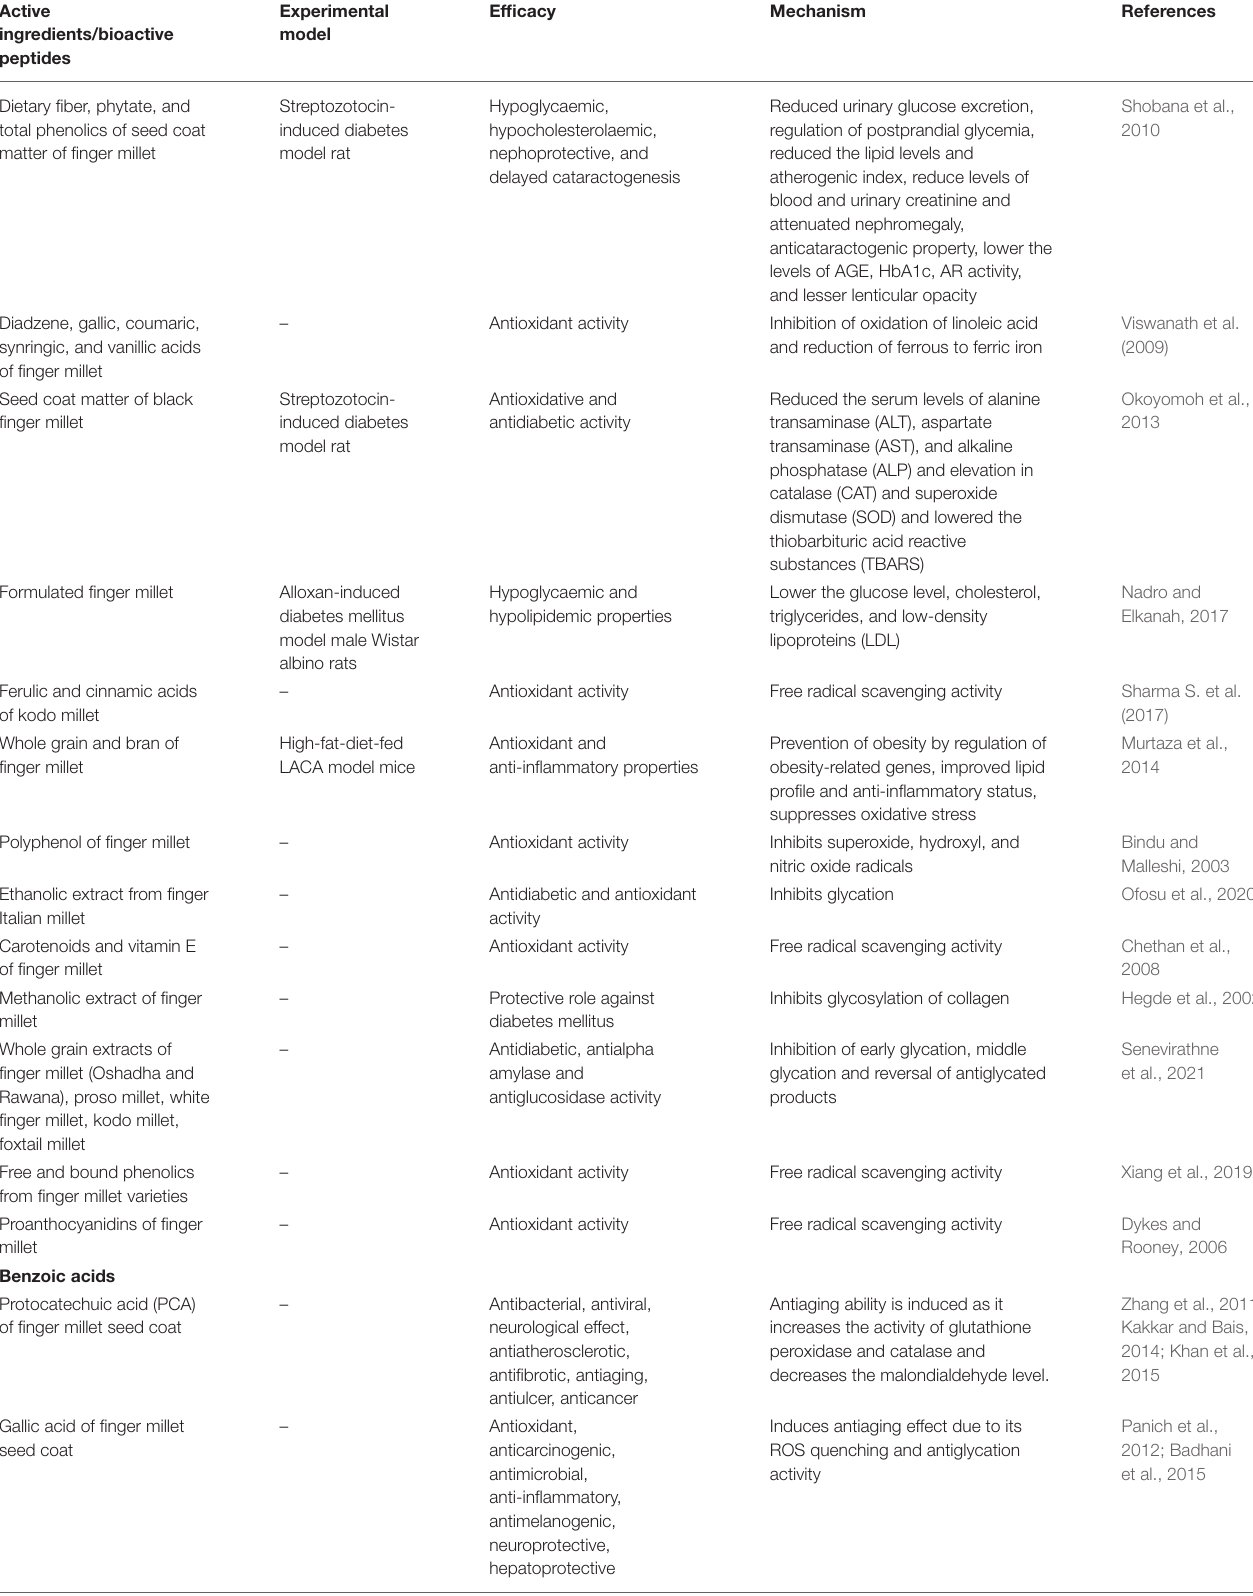
TABLE 2 | Active ingredients of finger millet and their mechanism of action for enhancing the lifespan. Active